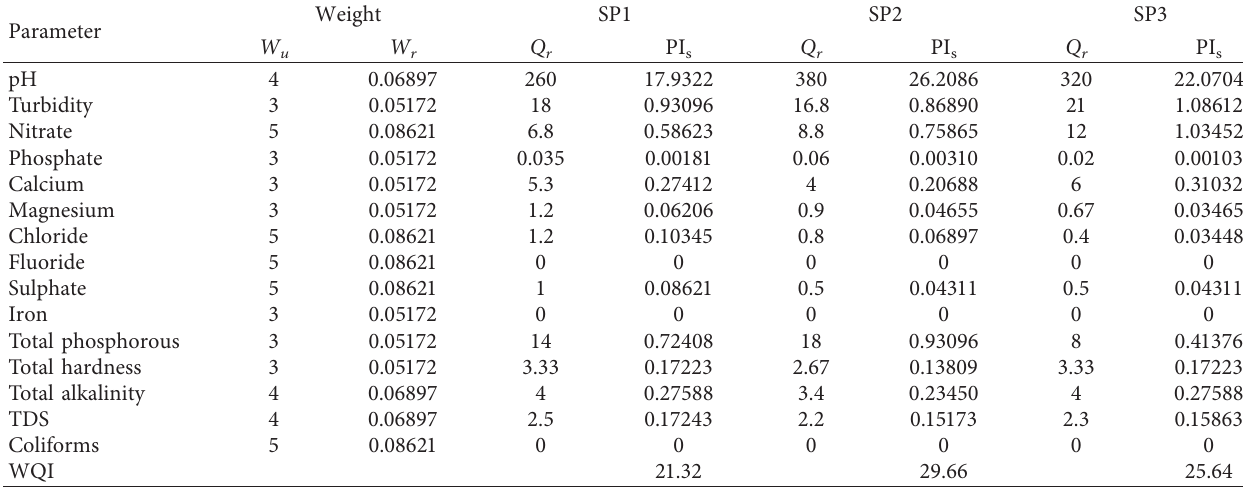
Table 4: Unit weight, relative weight, quality rating, and subindex values.